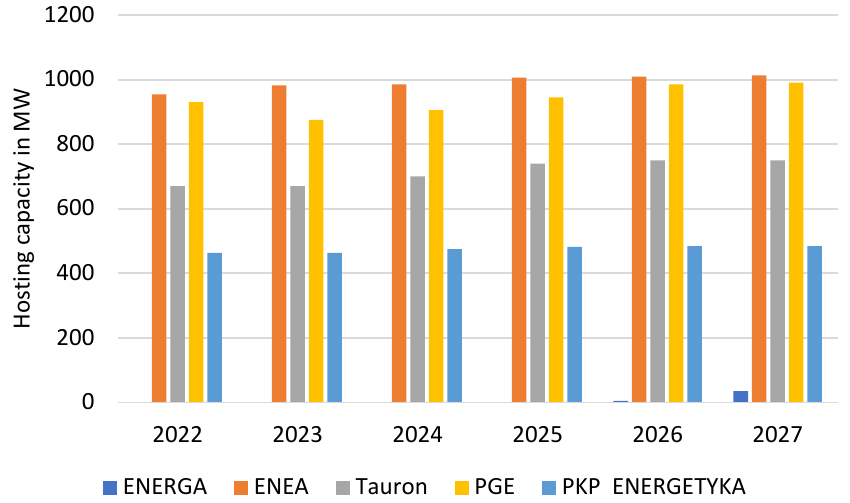
Figure 1. Hosting capacity of Polish distribution system operators (in MW) in 2022–2027 [40–44].